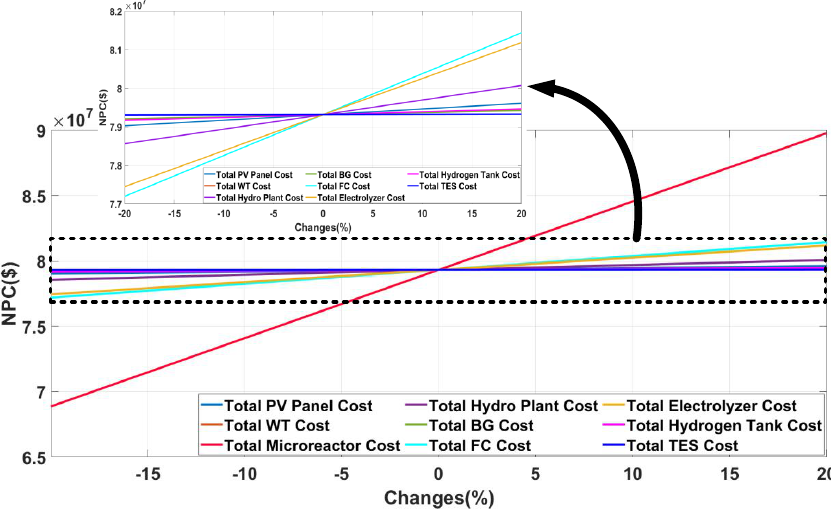
Figure 23. Impact on NPC due to variation in system component cost (Case-02).